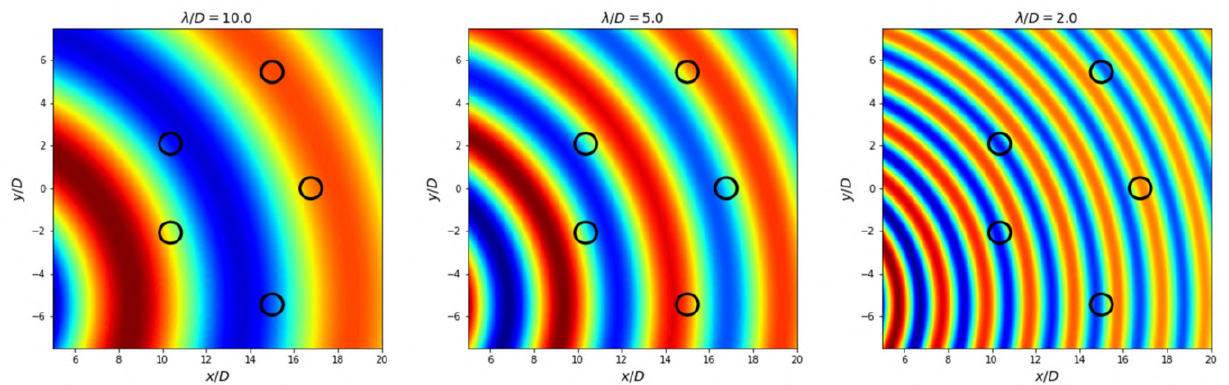
Figure 2. Radiated wave patterns from forced oscillations of body W 1